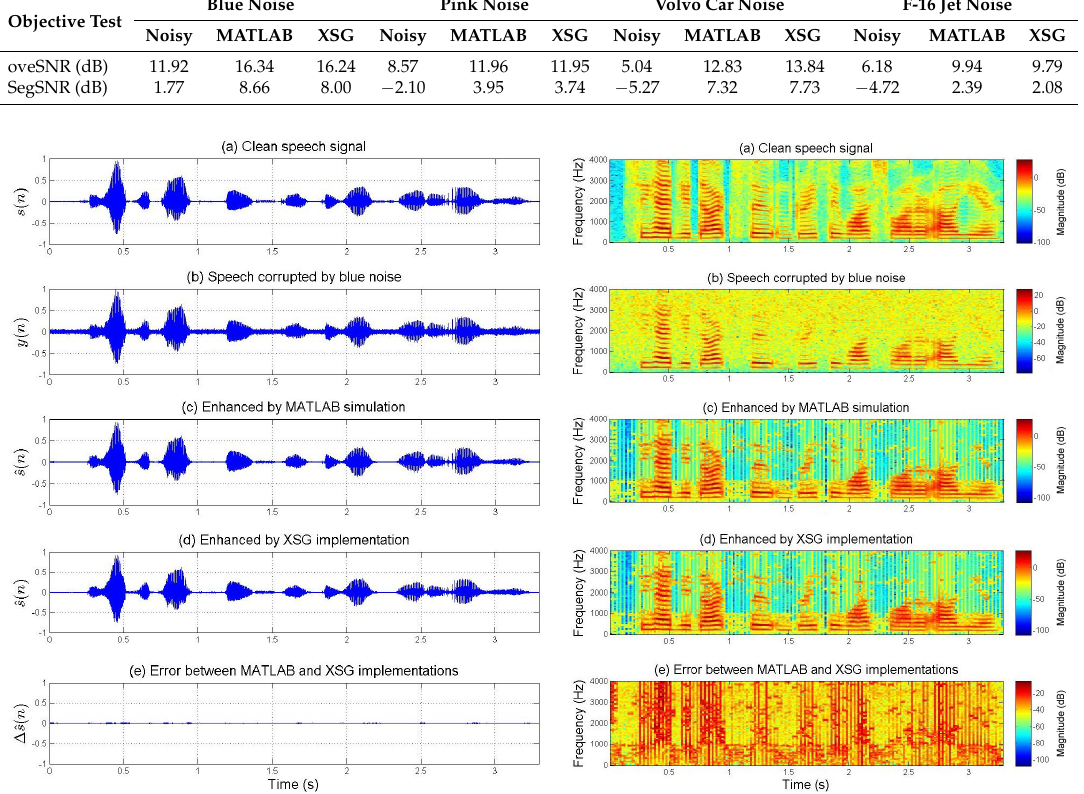
Table 2. Objective tests obtained for noisy and enhanced speech signals for various additive noises. XSG: Xilinx system generator; SNR: segmental signal-to-noise ratio Objective Test